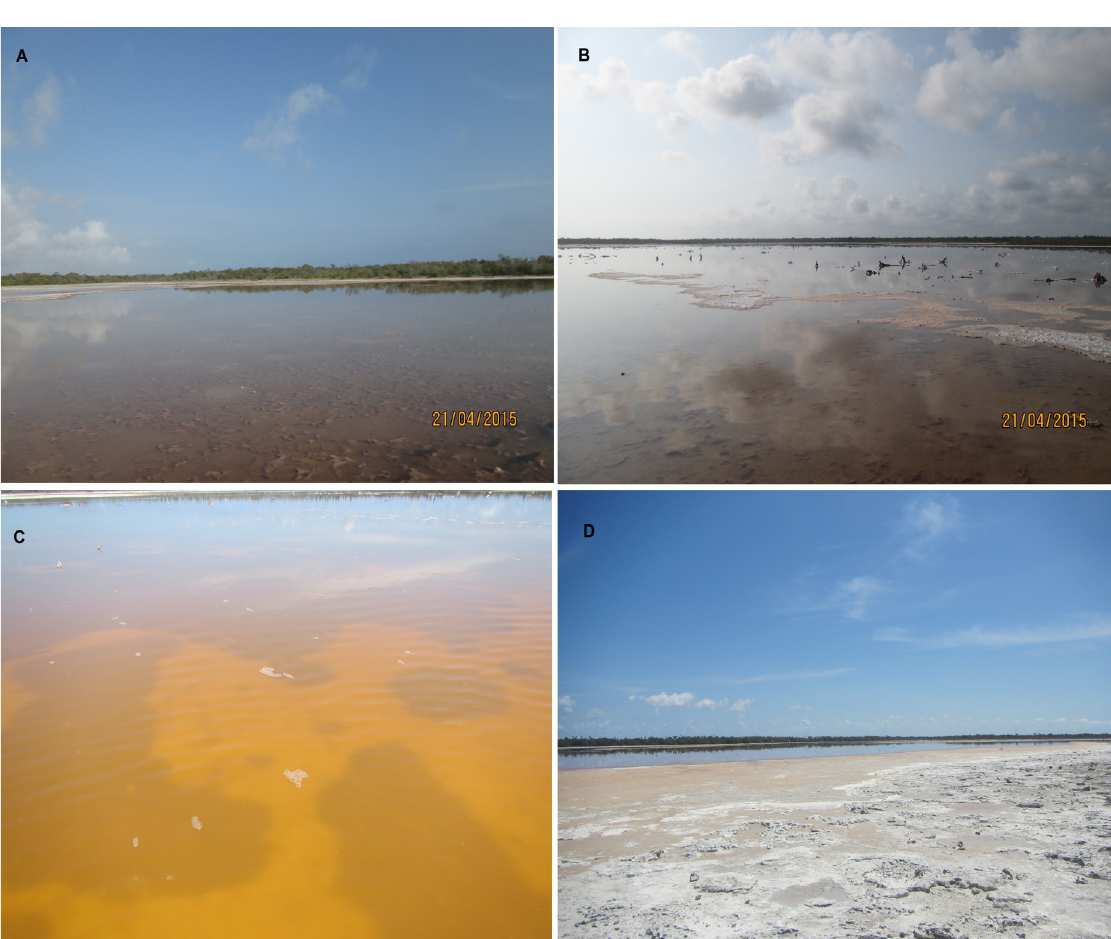
Figure 5. The stromatolites of Los Caimanes Lagoon. A) Partial view of Los Caimanes Lagoon with submerged stro- matolites. B) Partially submerged stromatolites. C) Submerged stromatolites in turbid waters. D) Exposed